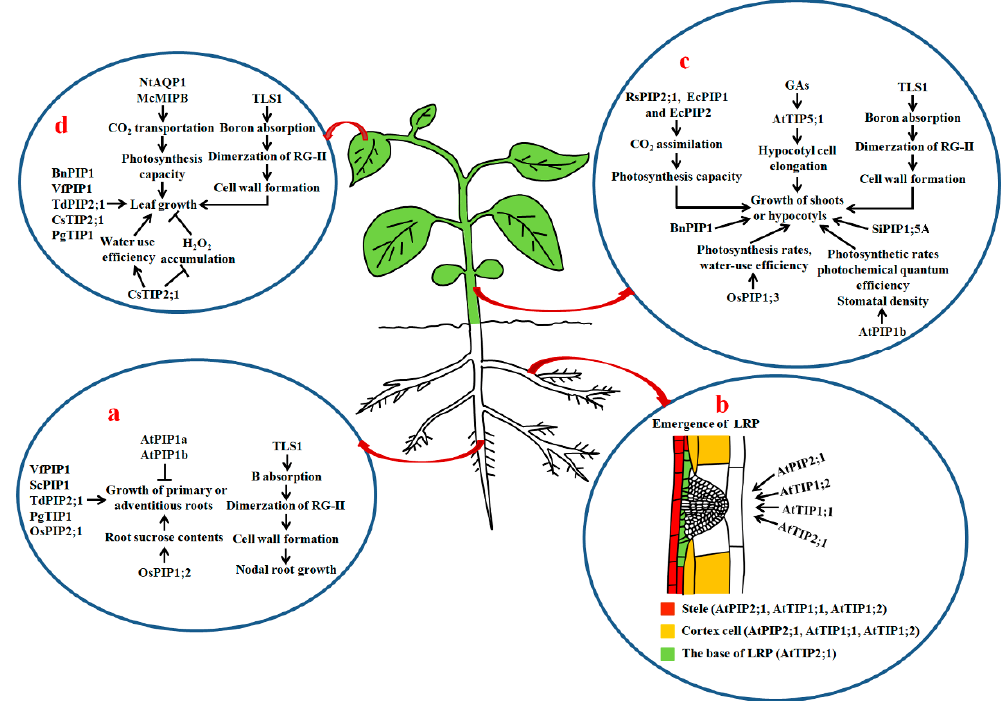
Figure 2. The roles of AQPs in the growth of roots, shoots, hypocotyls and leaves in plants. ( a ) Roles of AQPs in growth of primary roots, adventitious roots and nodal roots; ( b ) effects of PIPs and TIPs on lateral root formation. The expression or localization of AtPIP2;1, AtTIP1;1, AtTIP1;2 and AtTIP2;1 is shown in color; ( c ) roles of AQPs in shoot growth and hypocotyl elongation; ( d ) actions of AQPs in leaf growth. Thick up arrows represent the increase in L pr , the thin arrows show positive regulation, and bars show negative regulation. GAs: gibberellins; L pr : root hydraulic conductivity; LRP: lateral root primordium; RG-II: rhamnogalacturonan II; TLS1: maize tassel-less1.